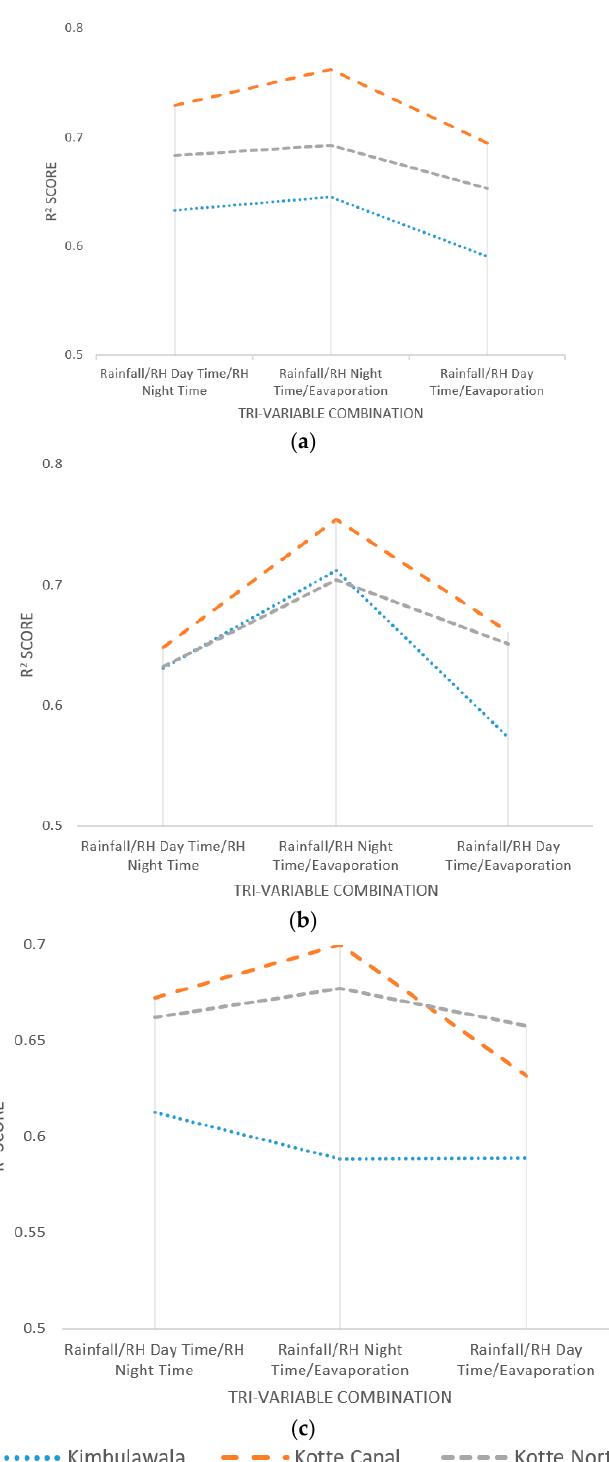
Figure 6. Tri-Variable Sensitivity Analysis (R 2 Score): ( a ) under the Levenberg Marquardt Algorithm; ( b ) under the Bayesian Regularization Algorithm; ( c ) under the Scaled Conjugate Gradient Algorithm.